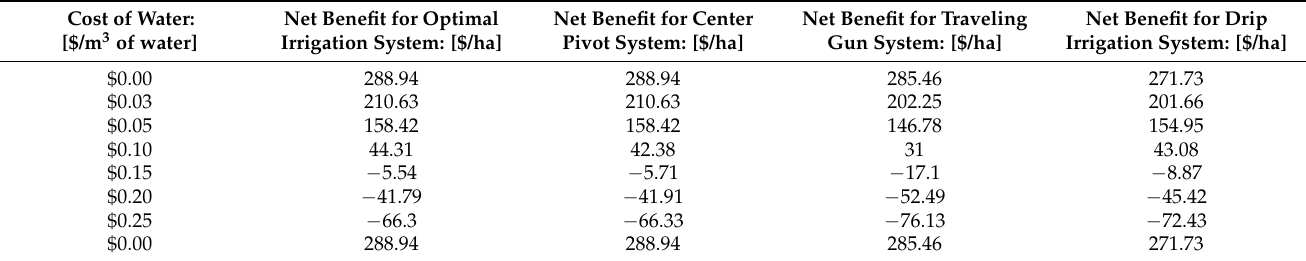
Table A7. Net benefit values associated with sorghum production for each irrigation system under various water cost values. Cost of Water: [$/m 3 of water]